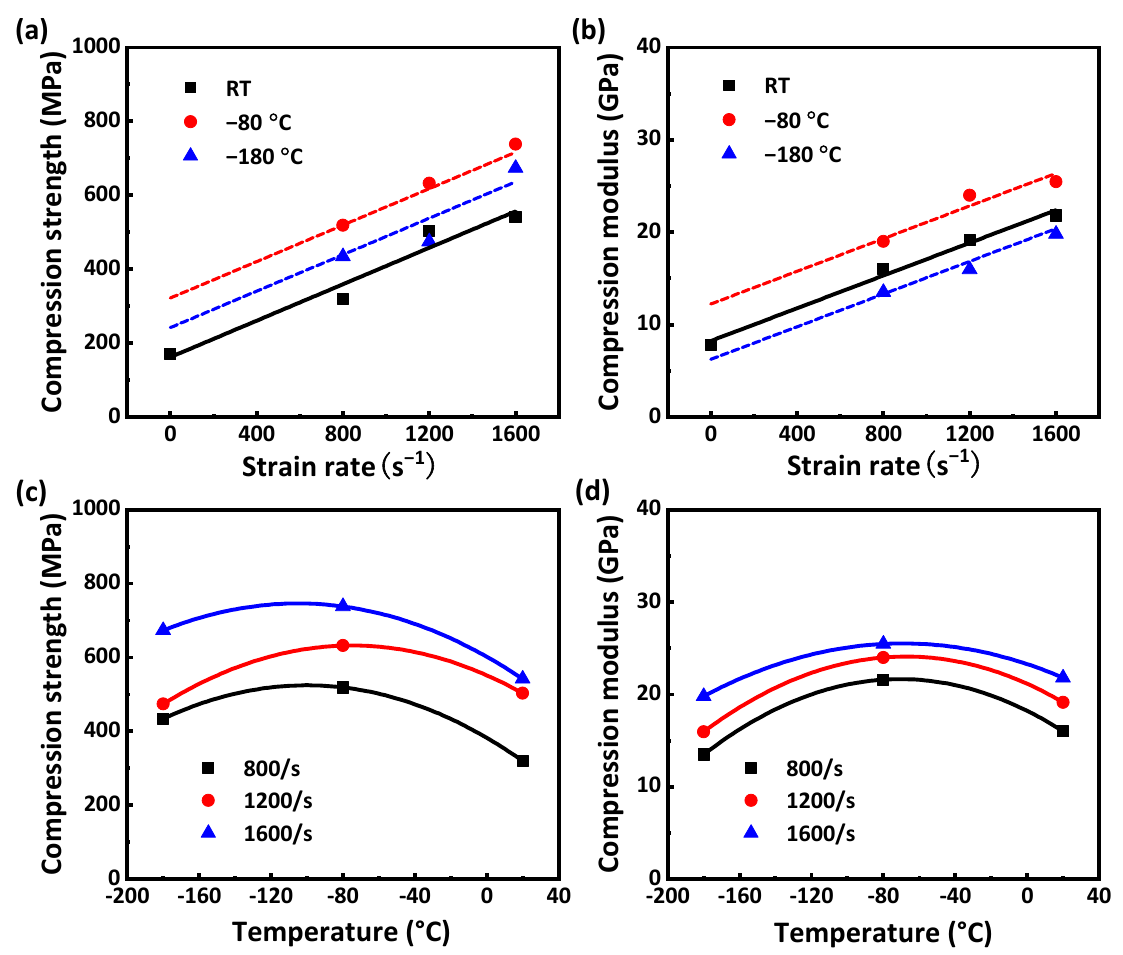
Figure 7. The relationship between mechanical properties of the dynamic compression sample and strain rate and temperature: ( a ) compression strength–strain rate, ( b ) compression modulus–strain rate, ( c ) compression strength–temperature, ( d ) compression modulus–temperature.